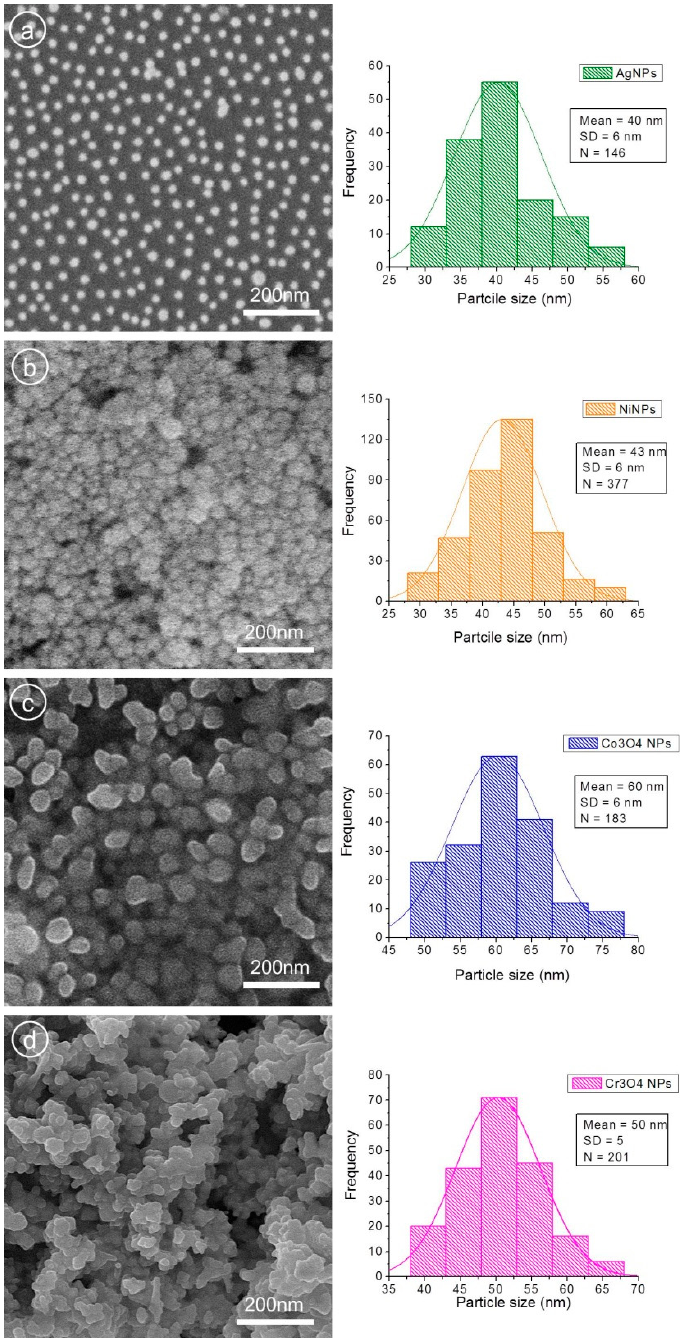
Figure 3. Right panel represents the SEM micrographs revealing the surface morphology, while left panel displays histograms showing the particle size distribution of prepared particles ( a ) AgNPs, spherical, with average particle size of 40 ± 6 nm, ( b ) NiNPs, spherical, with average diameter 43 ± 6 nm, ( c ) Co 3 O 4 NPs, spherical, with 60 ± 6 nm average dimeter, ( d ) Co 3 O 4 NPs, spherical and near spherical, with 50 ± 5 nm average size.